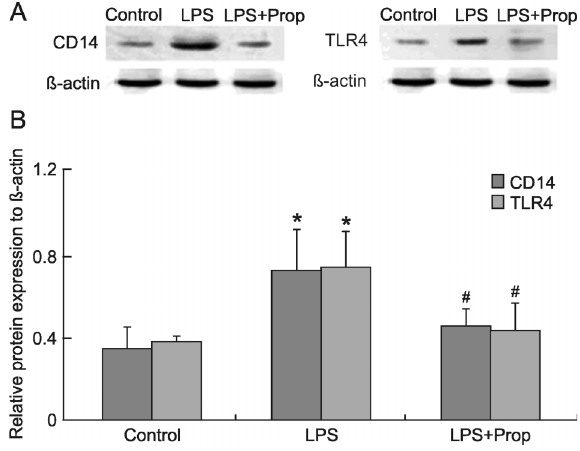
Figure 4. CD14 and TLR4 protein in rat lung. A , Representative Western blots are shown with the 54-kDa CD14 band, the 89-kDa TLR4 band, and the 43-kDa actin labeled band. B , Densitometry of all Western blot results from rat lungs of the control, LPS, and LPS + Prop groups. Densitometric values are presented as percentages of b -actin. Data are reported as means ± SD for n = 8 animals per experimental group. LPS = lipopolysacchar- ide; Prop = propofol. There was no significant difference between the control and LPS + Prop groups. *P , 0.05 compared to control; # P , 0.05 compared to LPS group (ANOVA followed by the post hoc Tukey